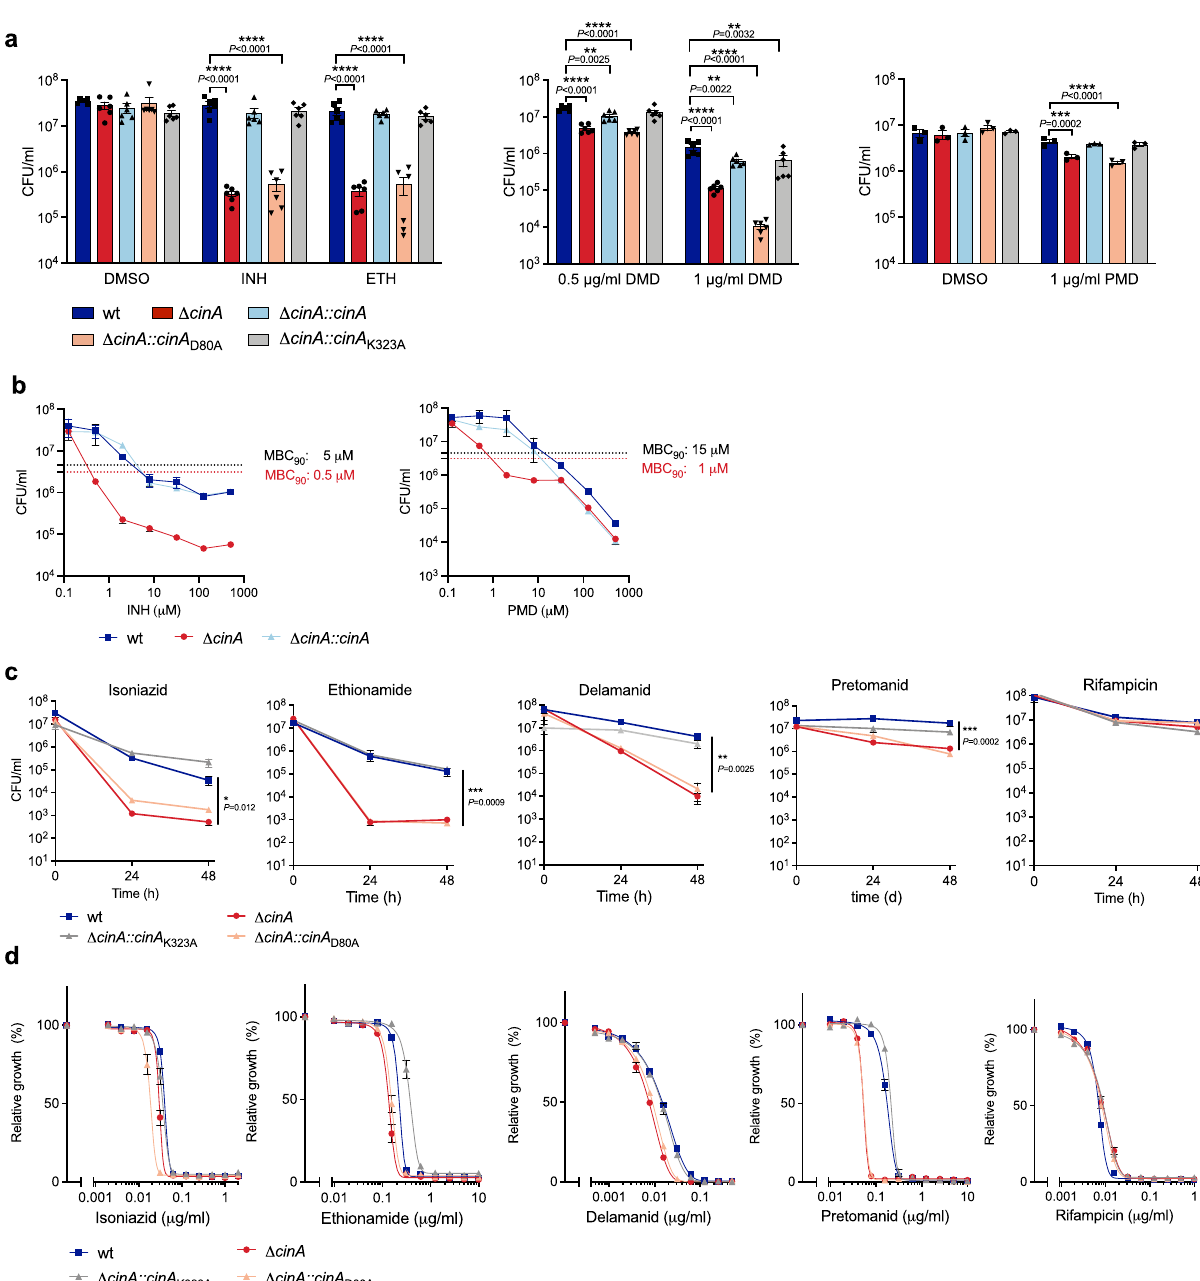
Fig. 3 CinA requires an intact pyrophosphatase domain to confer tolerance to isoniazid, ethionamide, delamanid, and pretomanid. a Bacteria were starved in PBS for 21 days and then exposed to 0.5 μ g/ml isoniazid (INH), 50 μ g/ml ethionamide (ETH), or were starved for 14 days and then exposed to 0.5 μ g/ml and 1 μ g/ml delamanid (DMD), 1 μ g/ml pretomanid (PMD) or equal amount of DMSO for 7 days and cultured on agar plates for CFU enumeration. Data are means ± SEM from two independent experiments each with triplicate cultures, except for PMD data, which are from one experiment with triplicate cultures. Statistical signi fi cance was assessed by one-way ANOVA followed by Dunnett ’ s multiple comparison test. ** P < 0.01, *** P < 0.001, **** P < 0.0001. b CFU quanti fi cation of the indicated strains after incubation in caseum mimetic for 4 weeks followed by 1 week treatment with isoniazid or pretomanid at the indicated concentrations. The stippled lines indicate a 10-fold reduction of wild-type and Δ cinA relative to DMSO-treated cultures and were used to determine the MBC 90 for these strains. Data are means ± SD of triplicate cultures and representative of two experiments. c CFU quanti fi cation of the indicated strains after incubation with 0.5 µ g/ml isoniazid, 4.5 µ g/ml ethionamide, 50 μ g/ml delamanid, 1 μ g/ml pretomanid, and 5 μ g/ml rifampicin in standard growth media. Data are means ± SEM from one or two independent experiments each with triplicate cultures. Statistical signi fi cance of the difference between wild-type and Δ cinA was assessed by two-tailed, unpaired t -test, * P < 0.05; **** P < 0.0001. d Impact of antibiotics on growth of the indicated strains. Data are means ± SEM of triplicate cultures and representative of at least two experiments. Source data are provided as a Source Data fi le.